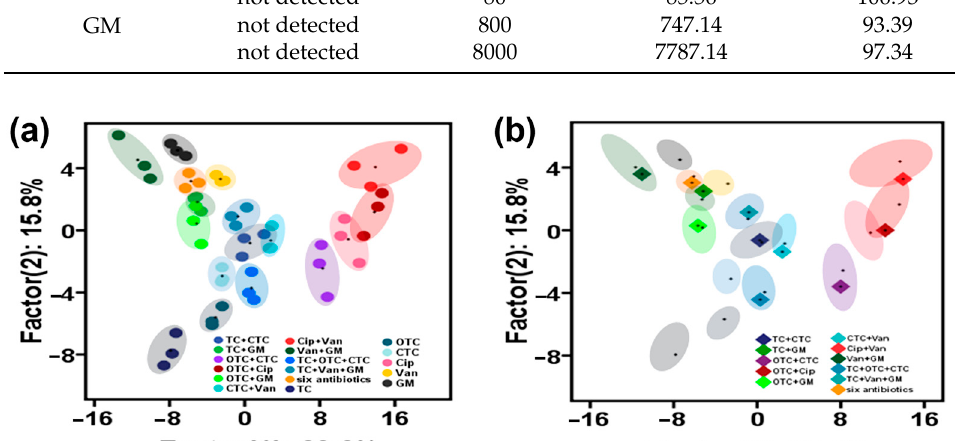
Figure 5. ( a ) LDA plot for the discrimination result of antibiotics mixtures with 95% confidence ellipses. ( b ) Identification results of unknown mixed antibiotics in river water.